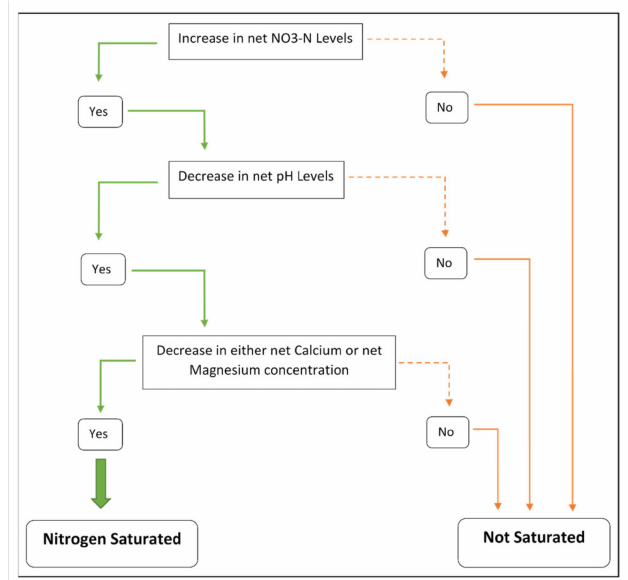
Figure 2. Flow diagram showing the physiological criteria used to identify grassland plots undergoing the initial stages of nitrogen saturation, as characterized by Aber et al.